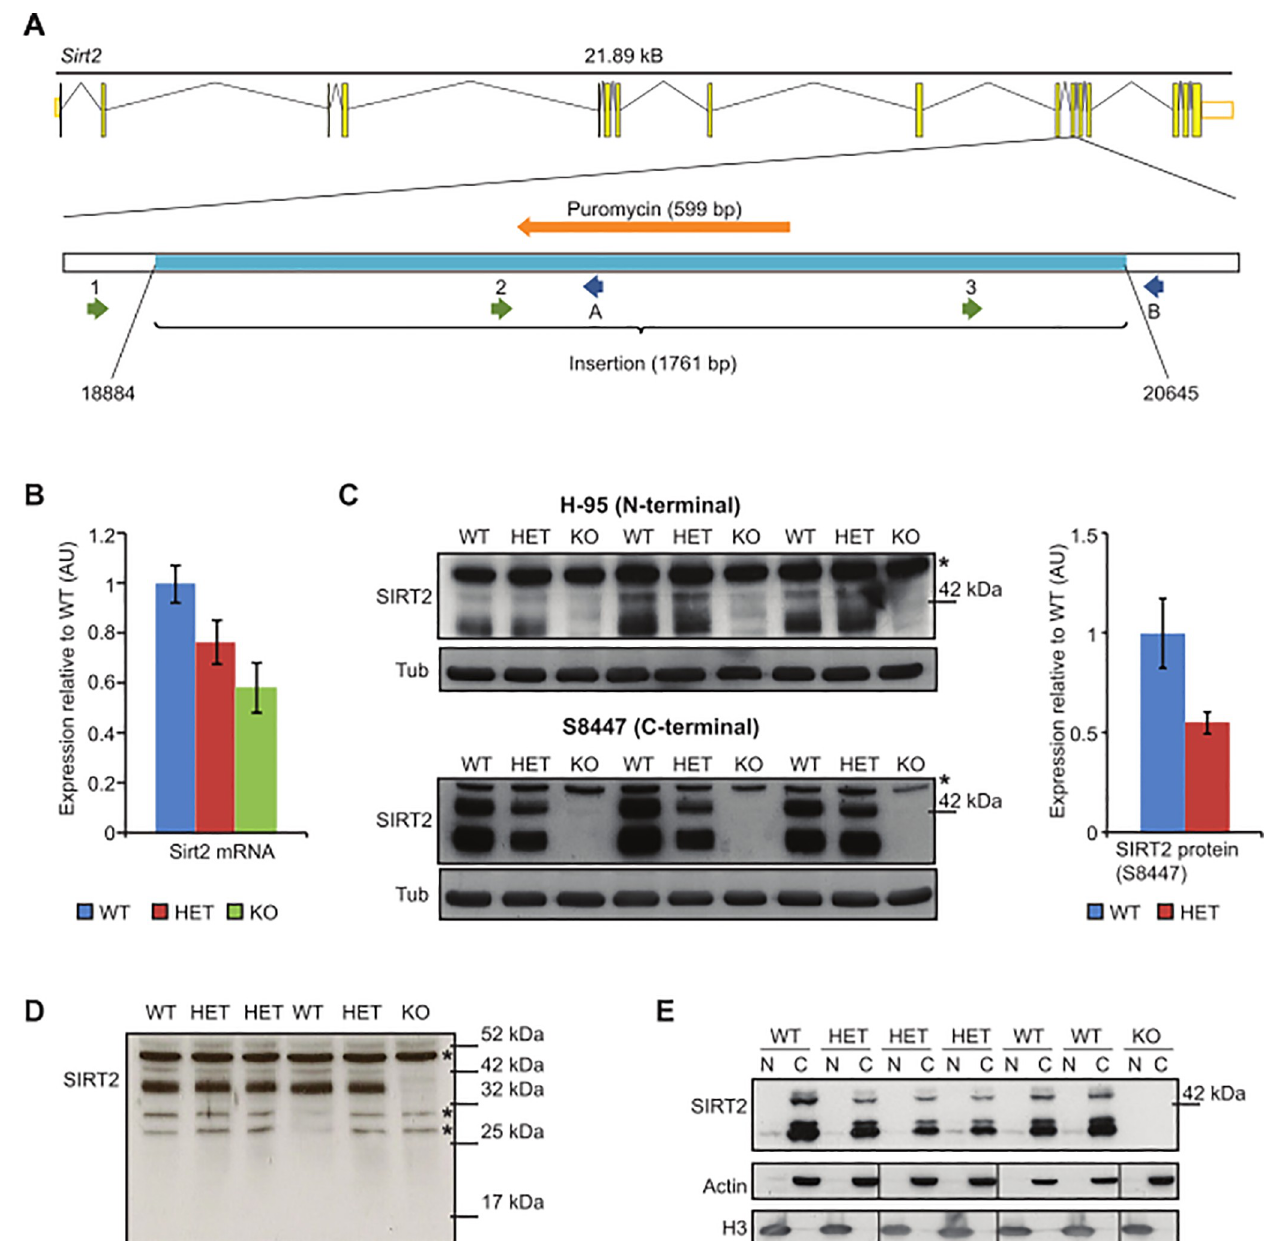
Fig 1. Reduction of Sirt2 mRNA and an absence of the SIRT2 protein in Sirt2 knock-out mice. ( A ) Exon-intron structure of the Sirt2 gene in mouse and the location of the insertion (light blue) in exon 11 (after nucleotide 18883) in Sirt2 KO mice. The positions of the sequencing forward and reverse primers are shown. 1- Sirt2 forward, 2- Sirt2 forward Seq2, 3- Sirt2 forward Seq3, A- Sirt2 reverse KO, B- Sirt2 reverse WT. ( B ) Cortical Sirt2 mRNA levels in 4 week old Sirt2 KO (KO), Sirt2 HET (HET) and wild type (WT) mice. Expression levels were normalised to the housekeeping genes Atp5b and Canx and expressed as fold change of WT levels ± SEM. n = 8/genotype. ( C ) Western blotting of KO, HET and WT brain lysates with SantaCruz H-95 (upper panel) and Sigma S8447 (lower panel) antibodies. The S8447 probed blot was used to quantify SIRT2 levels (both bands) between HET and WT (right panel). Values were normalised to α -tubulin (Tub) and expressed as fold change of WT ± SEM. � denotes a non-specific band. ( D ) Western blotting of KO, HET and WT brain lysates with SantaCruz H-95 antibody (long exposure) demonstrating that the Sirt 2 disrupting mutation does not result in the production of an N-terminal fragment of SIRT2. � denotes non-specific bands. ( E ) SIRT2 is localised to the cytoplasm. Purity of fractions was determined by measuring the expression of actin (C-cytoplasm) and H3 (N-nucleus). Black lines indicate splicing together of non-adjacent lanes or separate gels.